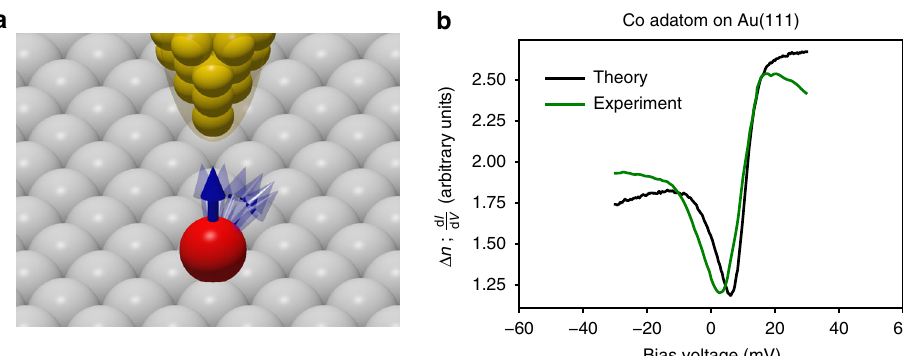
Fig. 1 Scanning tunneling spectroscopy probing the differential conductance of a Co adatom. a Illustration of the tip of a microscope scanning the surface of Au(111) on which an fcc Co adatom is deposited. b The differential conductance, dI / dV , measured at T = 6 K 17 compared to fi rst-principles results. As deduced from the change of the LDOS owing to the presence of spin-excitations, Δ n , the zero-bias anomaly stems from gaped spin-excitations and the presence of a many-body bound state, a spinaron, at positive bias voltage. The experimental data adapted with permission from IOP Publishing — Japan Society of Applied Physics — Copyright